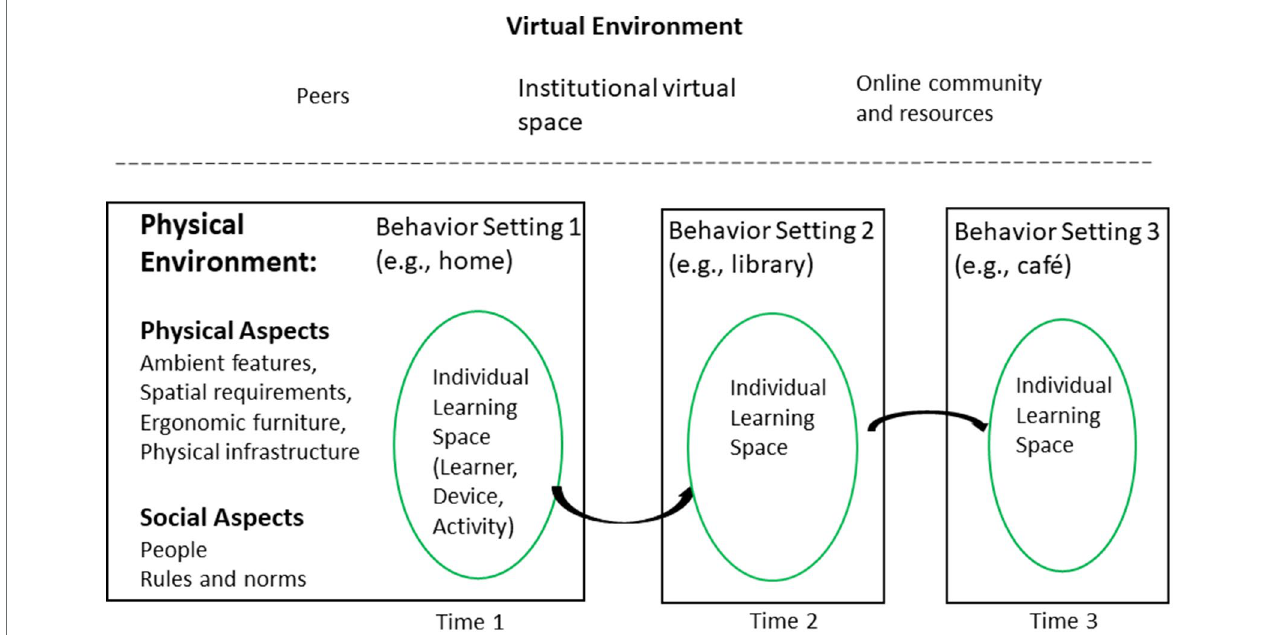
FIGURE 1 | A conceptual model for understanding the role of the physical environment in online distance learning in higher education.